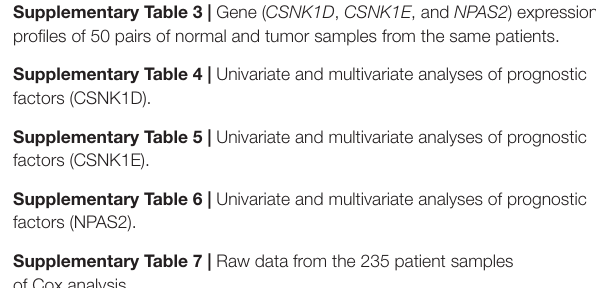
Supplementary Figure 1 | Relationships between DERG expression levels and survival rate in hepatic carcinoma. (A) PER1 , (B) PER2 , (C) PER3 , (D) ARNTL , (E) NR1D1 , (F) PRKAG2 , and (G) RORA .